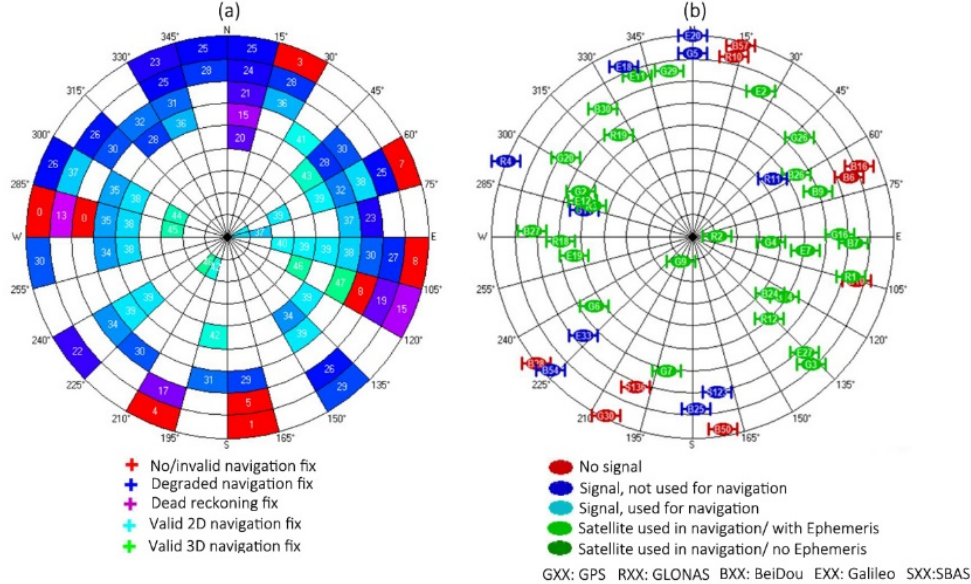
Figure 9. Sky view for a specific location for the antenna of u-blox ZED-F9P: ( a ) the quality of sky view and ( b ) the position of satellites that were used in navigation.